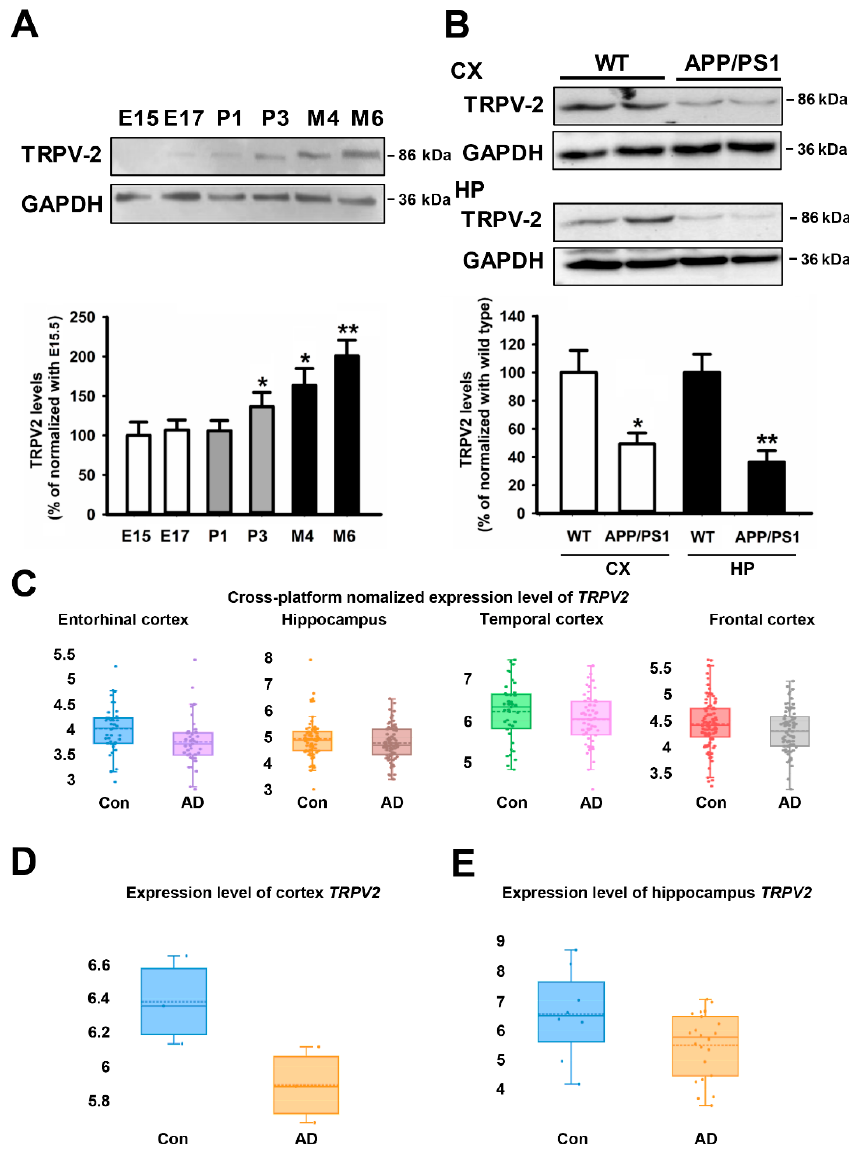
Figure 1. TRPV2 levels were decreased in both AD patients and APP/PS1 mice. ( A ) The TRPV2 levels were measured in the brain whole-protein extracts from mice at the indicated age (E is embryos, P is days and M is months). The data are represented as the mean ± SEM ( n = 4 mice/group). * p < 0.05, and ** p < 0.01 are compared to the E15.5 by the Tukey’s test. ( B ) Cortex and hippocampus protein extracts were obtained at 6 months of age from wild-type (WT) and two transgenic AD mice models (APP/PS1) who were subjected to the TRPV2 antibody. The data are represented as the mean ± SEM for four different mice per genotype. * p < 0.05, and ** p < 0.01 compared to controls as obtained by the Student’s t -test. ( C ) Transcriptional expression levels of TRPV2 in entorhinal, temporal, and frontal cortex and hippocampus tissues of the patients with AD in the cross-platform database (entorhinal cortex: GSE26927, GSE26972, GSE48350, GSE5281; hippocampus: GSE28146, GSE29378, GSE36980, GSE48350, GSE5281; temporal cortex: GSE29652, GSE36980, GSE37263, GSE5281; frontal cortex: GSE12685, GSE36980, GSE48350, GSE5281, GSE53890, GSE66333; control, n = 19; AD patient, n = 19). ( D ) Transcriptional downregulation of TRPV2 in the entorhinal cortex of the tissue samples from patients with AD in the GSE26972 database (control, n = 19; AD patient, n = 19). ( E ) Transcriptional downregulation of TRPV2 in the hippocampus of the tissue samples from patients with AD in the GSE28146 database (control, n = 19; AD patient, n =